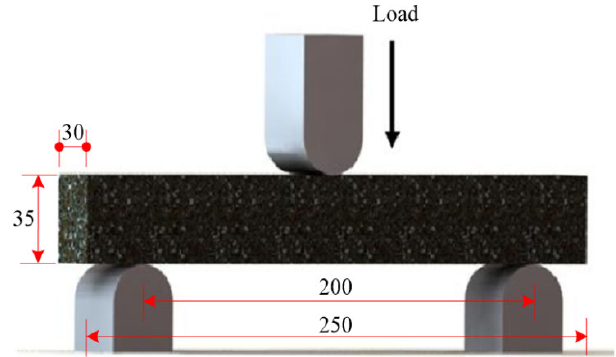
Figure 16. Loading schematic diagram of trabecular bending test (mm).